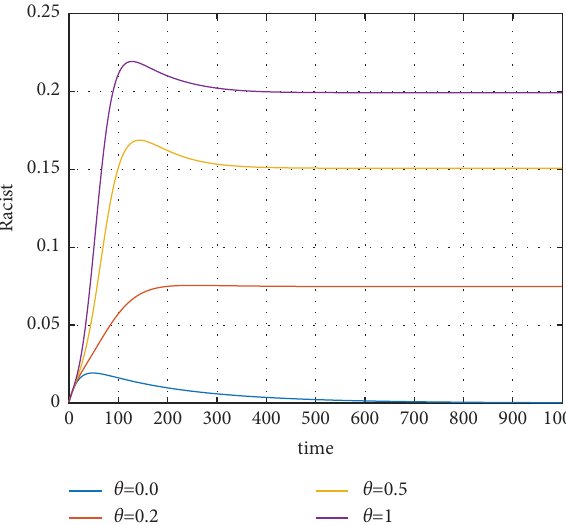
Figure 11: Te impact of θ on R ( t ) , if ξ � 0 . 2.